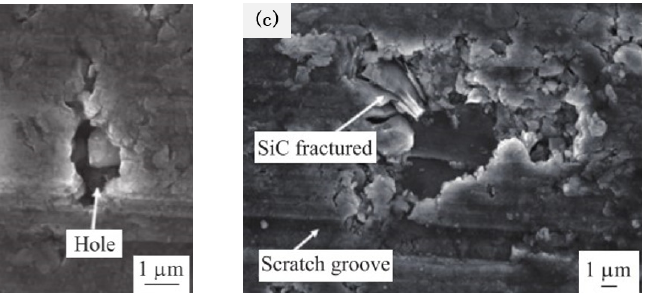
( c ) Figure 7. Schematic diagram of the removal method of SiC particles. ( a ) Force diagram of SiC; ( b ) low interface strength; ( c ) high interface strength. In SiCp/Al composites, the interface between the matrix and particle is both weak (weak interface) and strong (strong interface). The weak interface is shown in Figure 7b. During the milling process, the weak interface between the particle and matrix is prone to interface crack, which causes the whole particle to overturn, flow out, or press in, forming a cavity and crack. The strong interface is shown in Figure 7c. When the interfacial strength is greater than the fracture strength of the silicon carbide particles, the matrix